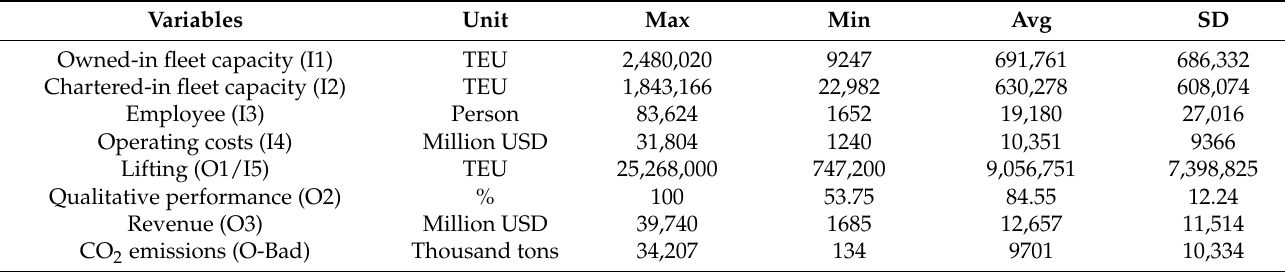
Table 15. Statistical analysis of input and output